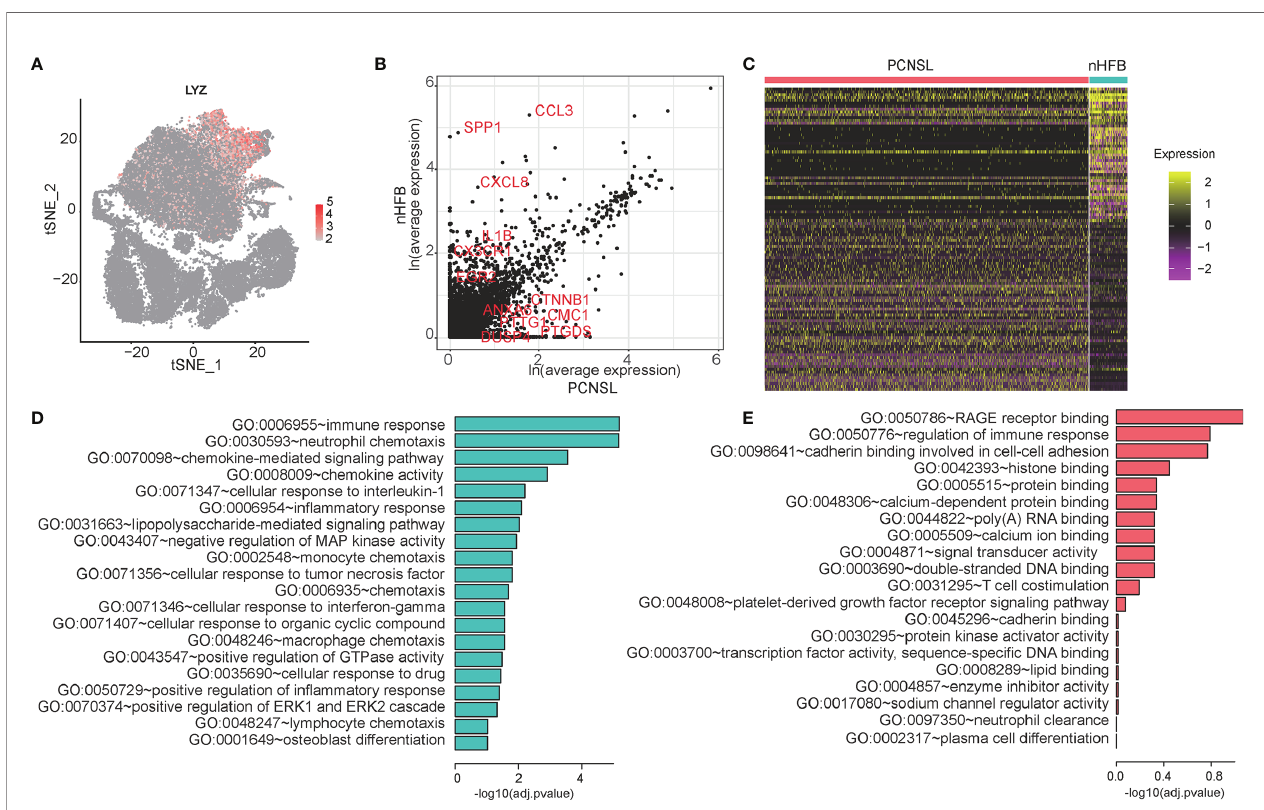
FIGURE 4 | The differential expression analysis of macrophage between cancer and normal samples. (A) The expression distribution of the macrophage cell marker gene – LYZ in all cells. (B) The scatter plot of genes selected fi ve signi fi cant DEGs in the macrophage cell population between cancer and normal samples. (C) The heatmap of DEGs of macrophage. (D, E) The GO categories of down-regulated genes (green) and up-regulated genes (red) in PCNSL samples compared with normal